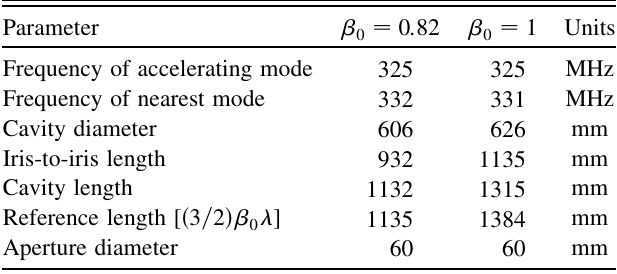
TABLE III. Cavity parameters, 325 MHz, (cid:1) 0 ¼ 0 : 82 and 1 . (cid:1) 0 ¼